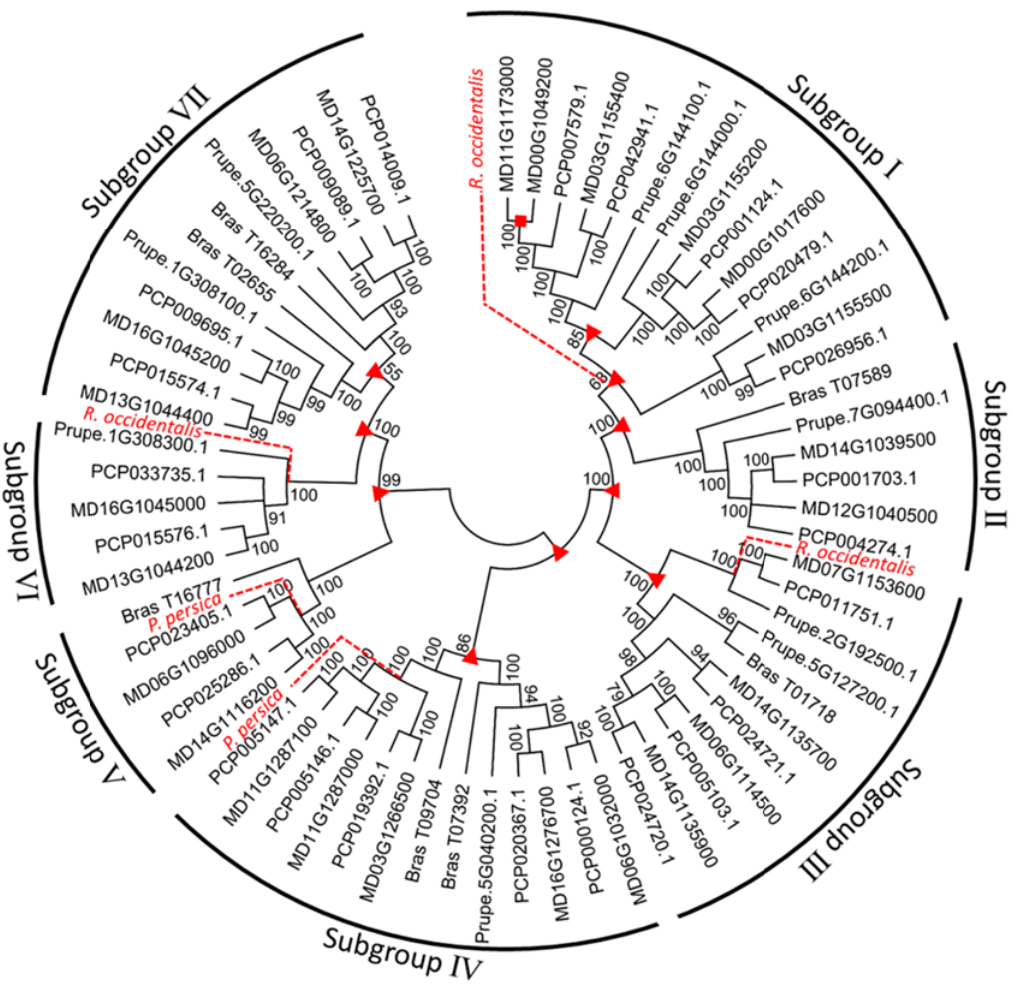
Figure 3. Phylogenetic tree analysis of genes encoding ALMT in Rosaceae using the neighbor-joining (NJ) method. Recent and old duplication events are indicated by the red square and triangle, respectively. Bootstrap values (higher than 50%) are shown near branched lines. Gene loss is indicated by red dash line.